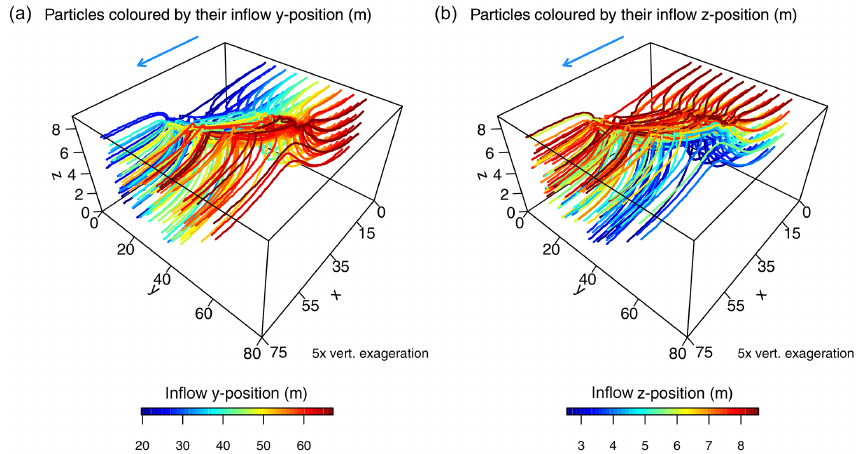
Figure 7. Particles coloured by their (a) y coordinate position and (b) z coordinate position on the inflow face. The blue arrows indicate the main flow